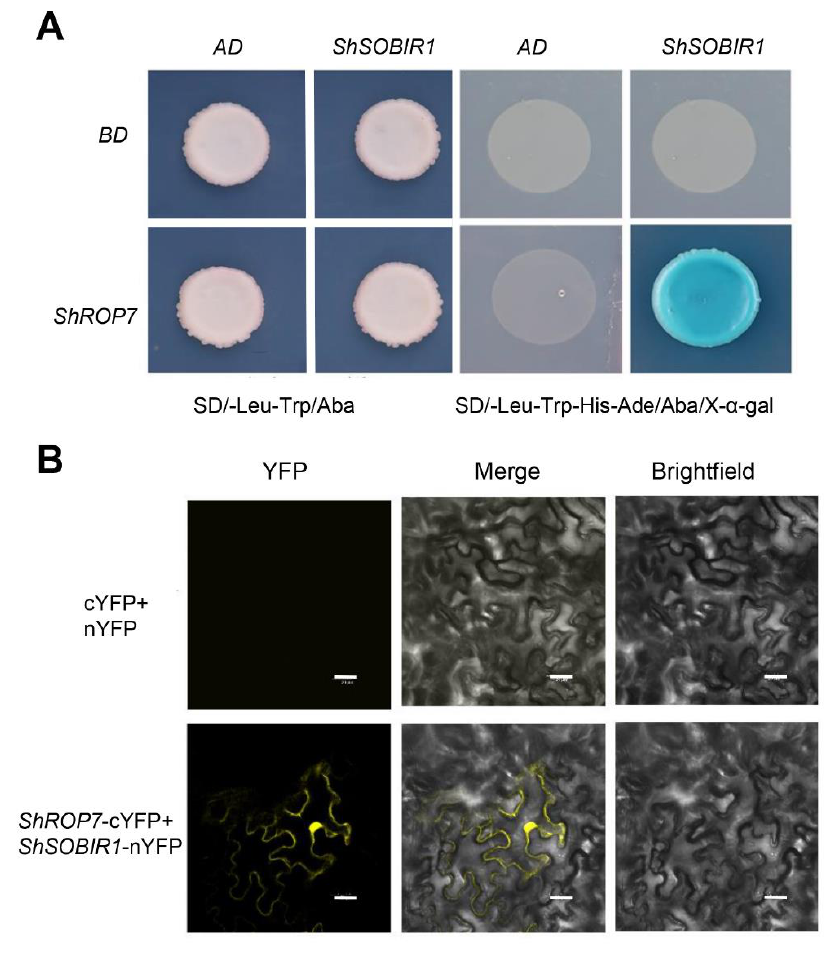
Figure 8. ShROP7 interacts with ShSOBIR1. ( A ) Interaction of ShROP7 and ShSOBIR1 in a yeast two-hybrid system. ( B ) Bimolecular fluorescence complementation (BiFC) analysis of the interaction between ShROP7 and ShSOBIR1. Bars = 20 μm.